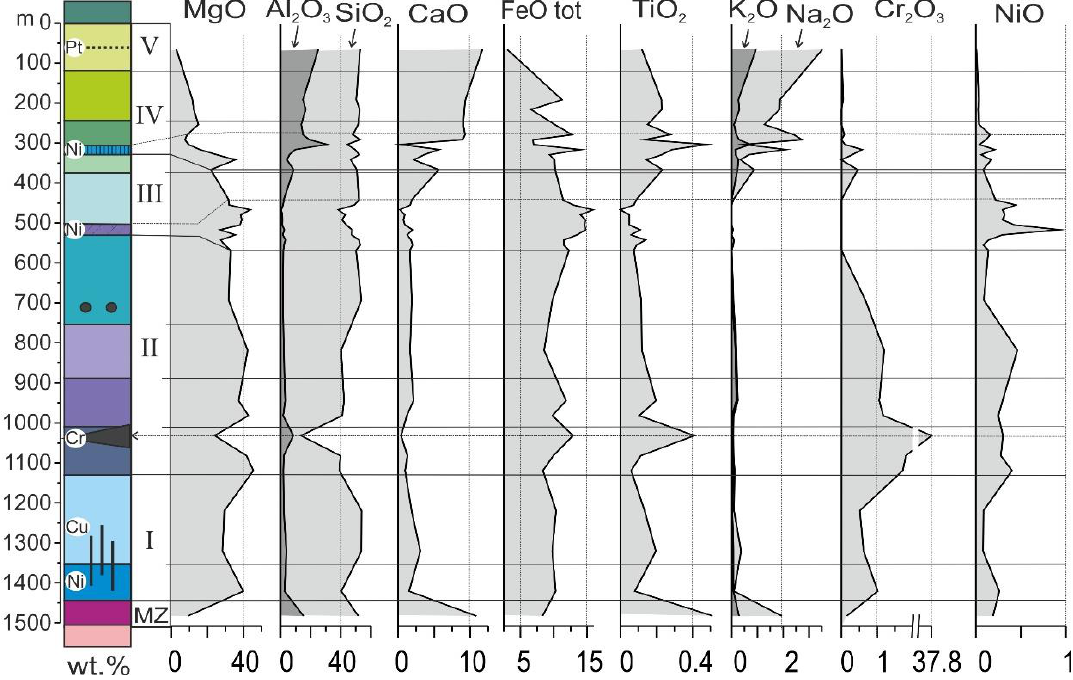
Figure 6. Content variations of petrogenic components and ore elements in rocks according to the generalized vertical cross-section of the Monchepluton. For the description, see Figure 3. The MgO distribution at the generalized cross-section vividly indicates a process of consecutive accumulation of olivine and orthopyroxene accumulating rocks, whereas the distribution of other components is associated with the crystallization and accumulation of plagioclase. The content of anorthite (An%) in plagioclase from the orthopyroxenes of Mt. Nittis varies from 67.4 to 51.5. The crystallization differentiation of magmatic melt was